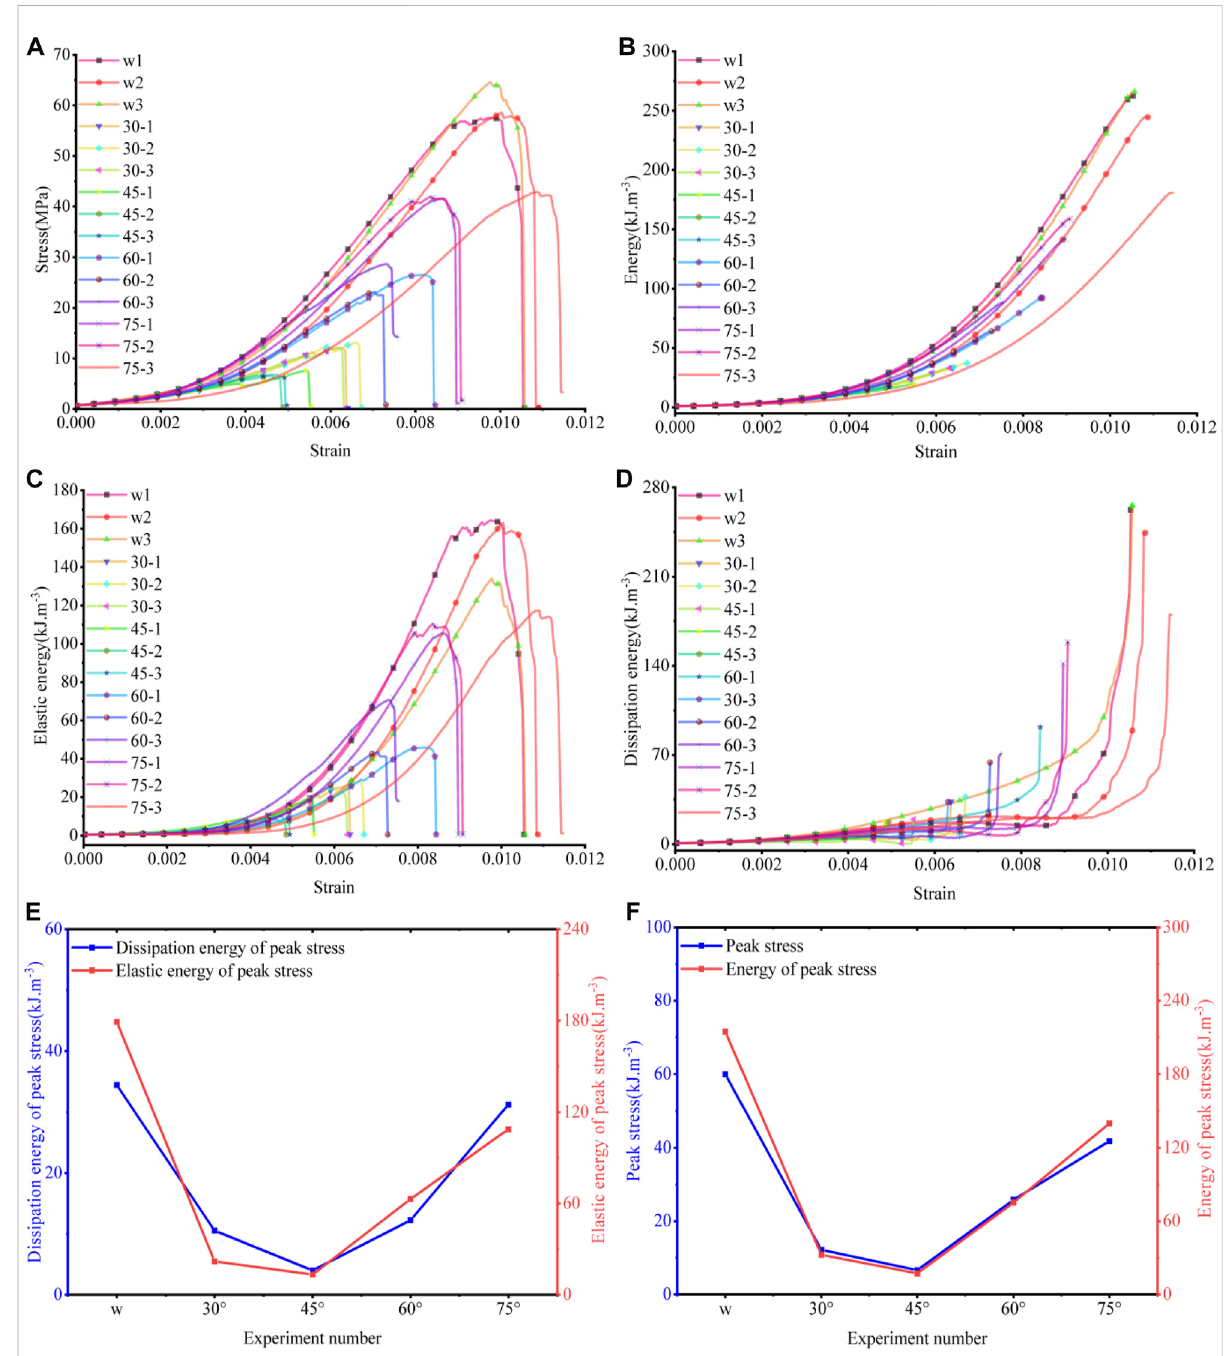
FIGURE 3 Mechanical characteristics. (A) stress – strain characteristics, (B) total energy characteristics, (C) elastic energy characteristics, (D) dissipation energy characteristics, and (E,F) average mechanical and energy values for each group of rock